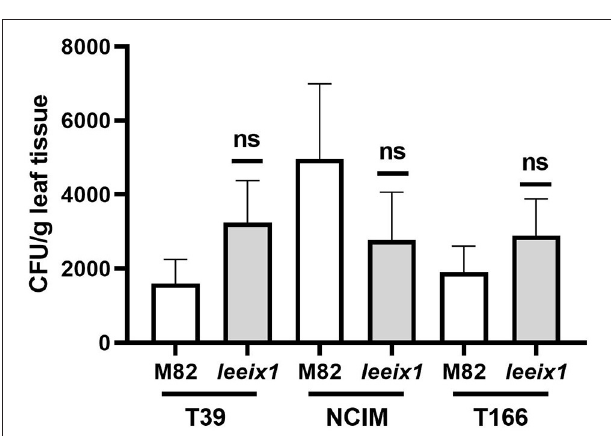
FIGURE 6 | Trichoderma colonizes WT and Leeix1 leaves to similar levels. CFU amount of indicated Trichoderma strains in leaf tissue. Trichoderma spp. were cultured on potato dextrose agar (PDA) (Difco Lab) plates and incubated at 25 ◦ C for 7 days. Conidia concentration was adjusted to 10 6 cells mL − 1 , and sprayed onto plants. Two weeks after treatment, leaves were harvested and washed in water with thorough shaking. Leaves were then removed and sterilized in bleach for 2min, then ground with a mortar and pestle. One gram of the ground tissue was re-suspended in 1mL water. Serial dilutions were plated on PDA plates containing 0.02% of rose bengal. Resultant colonies were counted to determine CFU count in the leaves. Graph represents average CFU per leaf ± SEM of three independent experiments, N = 8. No significant differences among samples were found (two-tailed t